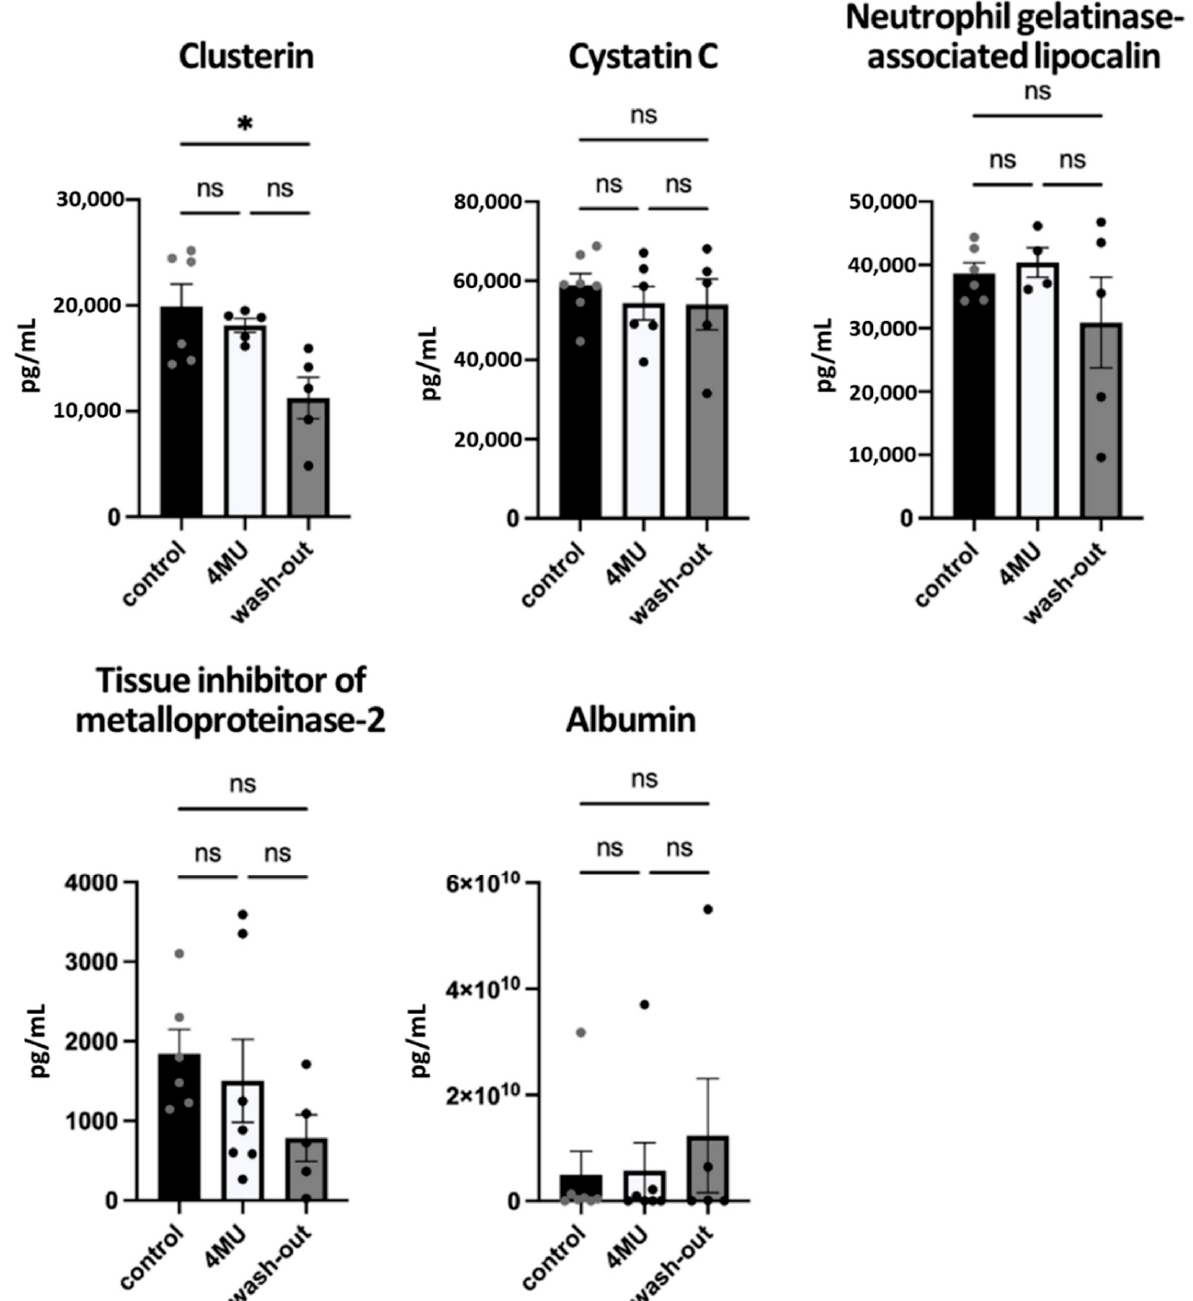
Figure 5. Urinary biomarkers used to assess the nephrotoxicity. Bar graphs show the level of urinary markers of renal injury. Data are expressed as a mean ± SEM; * p < 0.05 by one-way ANOVA with Tukey’s multiple comparisons test, n = 4 to 7. ns: no significance.